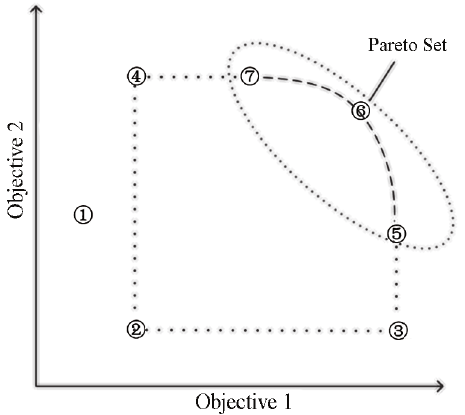
Figure 1. Multi-objective optimization problem